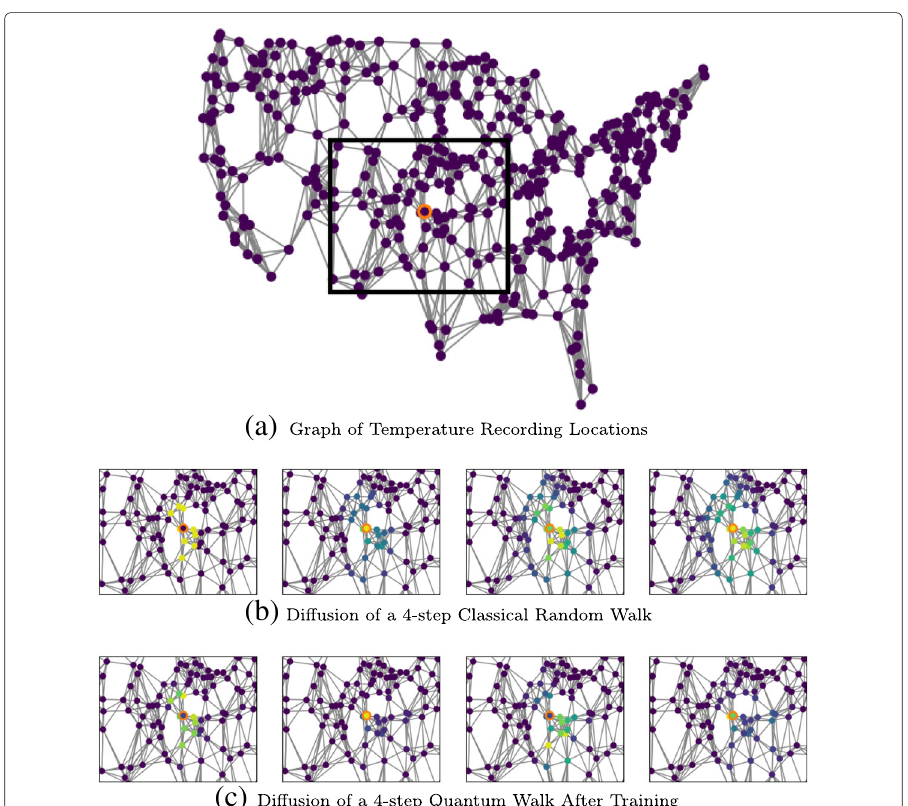
Fig. 3 Comparison of a classical walk and a learned quantum walk. The classical and quantum random walks evolve from left to right over 4 steps. Both walks originate at the highlighted node. At each step, the brighter colored nodes correspond to a higher probability of the random walker at that node. A classical walk, as used in GCN and DCNN, diffuses uniformly to neighboring nodes. The learned quantum walk can direct the diffusion process to control the direction information travels. The third and fourth steps of the quantum walk show the information primarily directed southeast. a Graph of Temperature Recording Locations b Diffusion of a 4-step Classical Random Walk c Diffusion of a 4-step Quantum Walk After